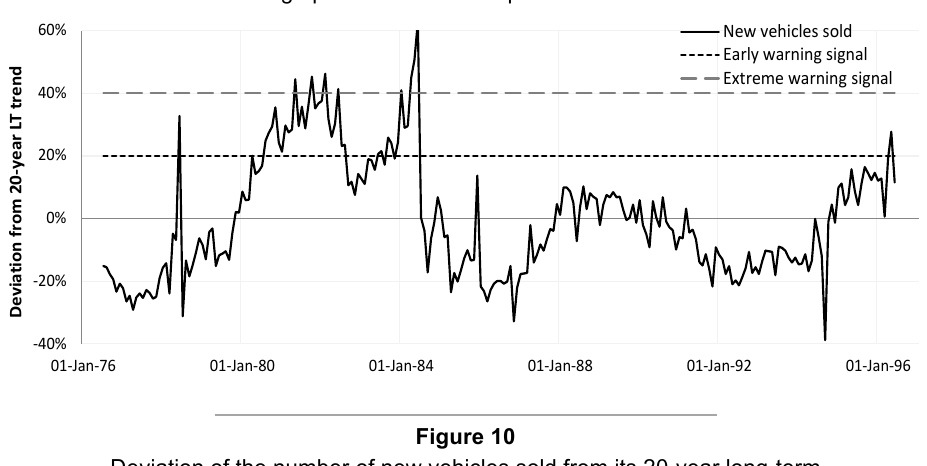
Deviation of the number of new vehicles sold from its 20-year long-term trend leading up to the 1997-1999 period of financial distress